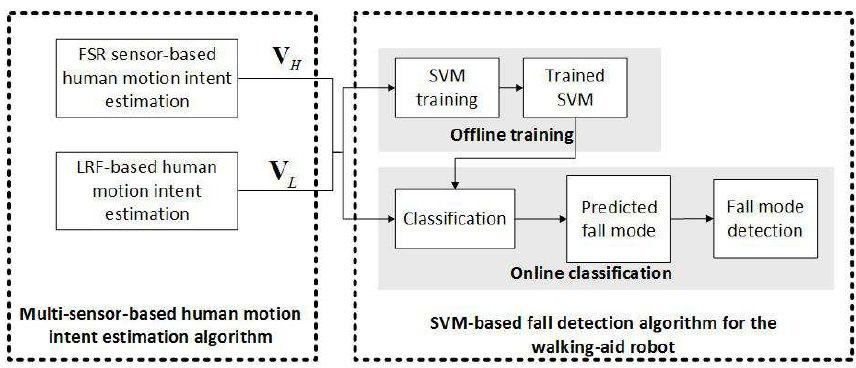
Figure 7. The fall detection algorithm for the walking-aid